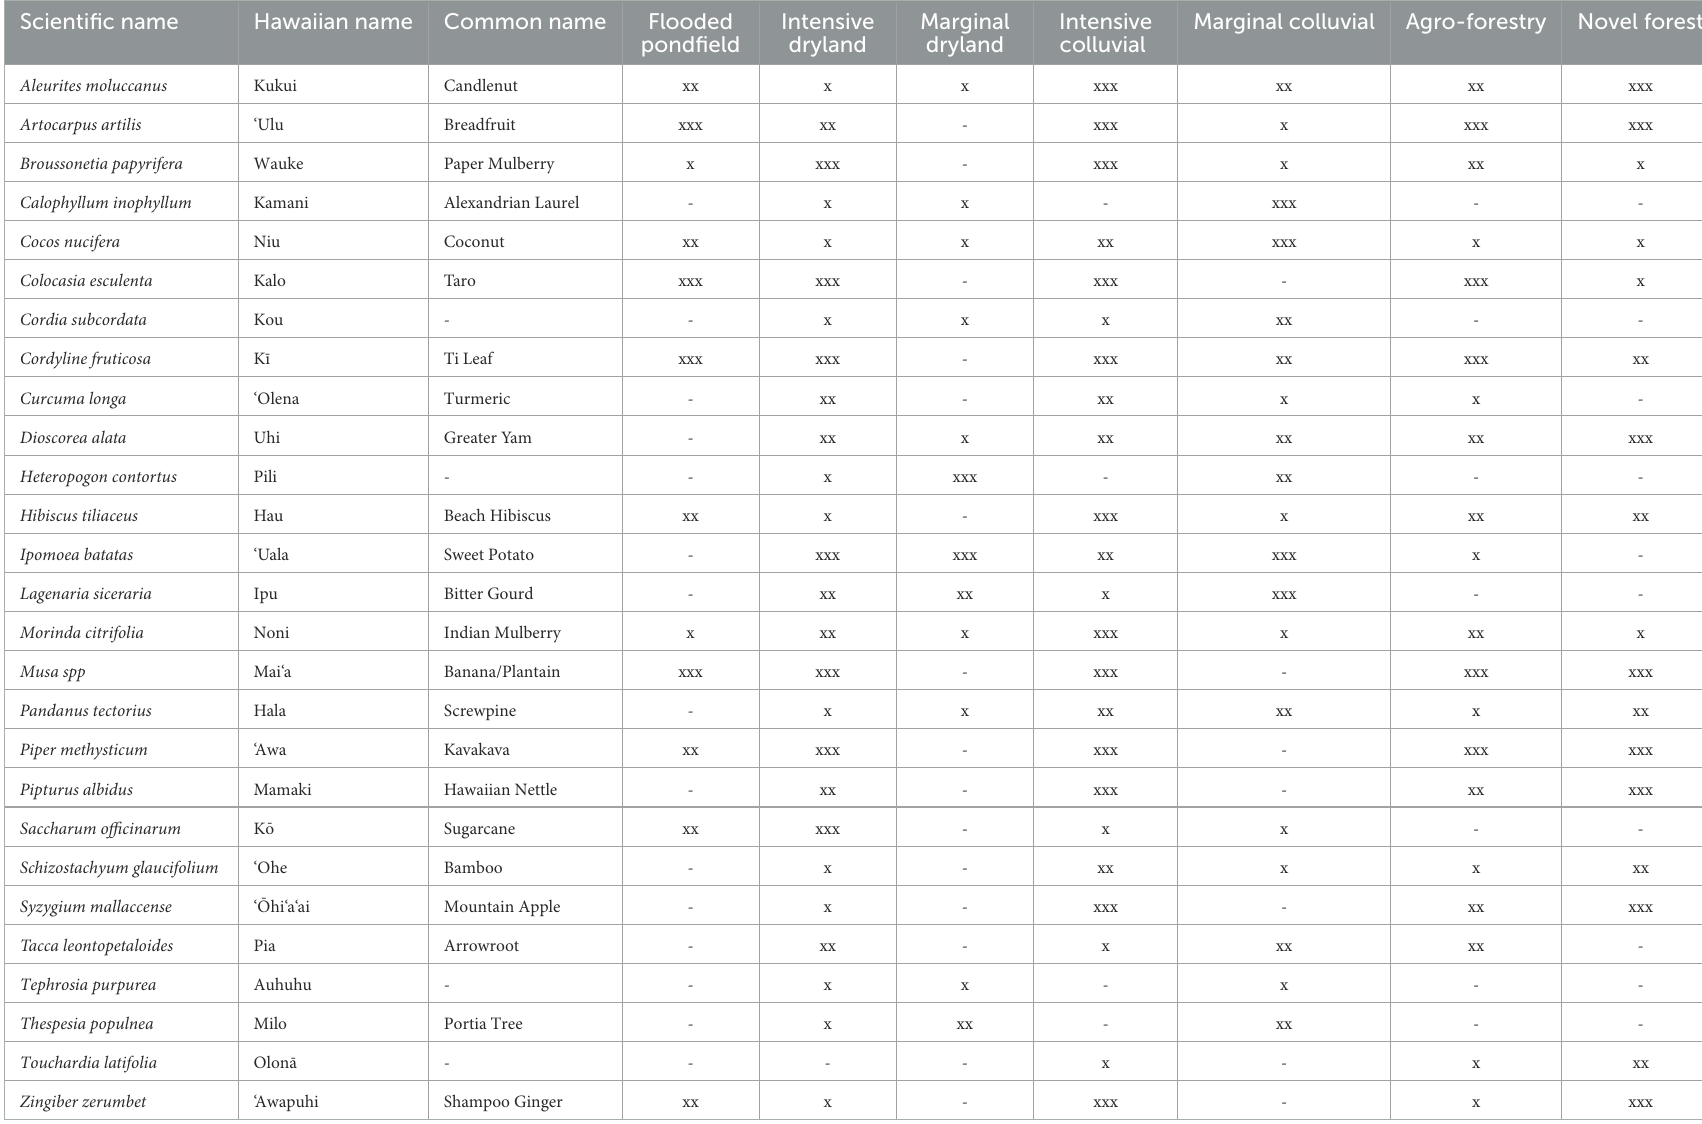
TABLE 4 Most utilized Hawaiian crop species for food, fiber, medicine, and ceremonial purposes and their association with the seven agroecological types modeled in this